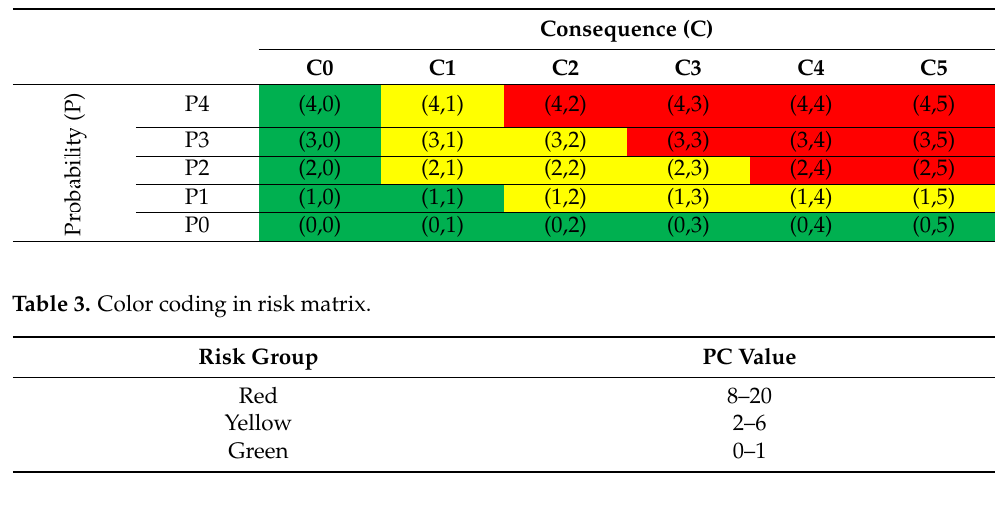
Table 2. Risk matrix showing classification of pipes based on their combined (P,C) values.